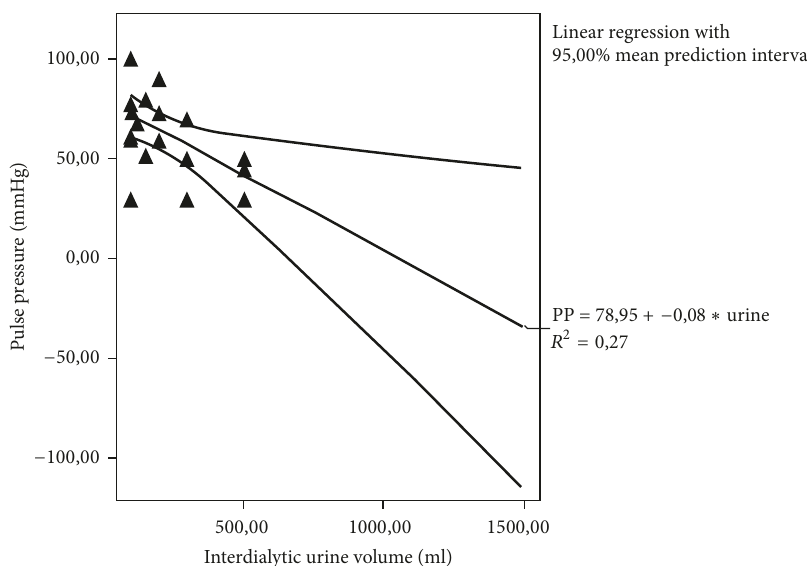
Figure 4: The correlation between pulse pressure and interdialytic urine volume ( 𝑟 = −0.481 , 𝑝 = 0.03